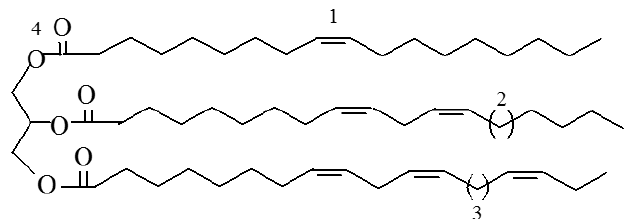
Figure 1. Structure of a triglyceride showing the reactive sites: 1 = double bond; 2 = monoallylic position; 3 = bisallylic position; 4 = ester group.